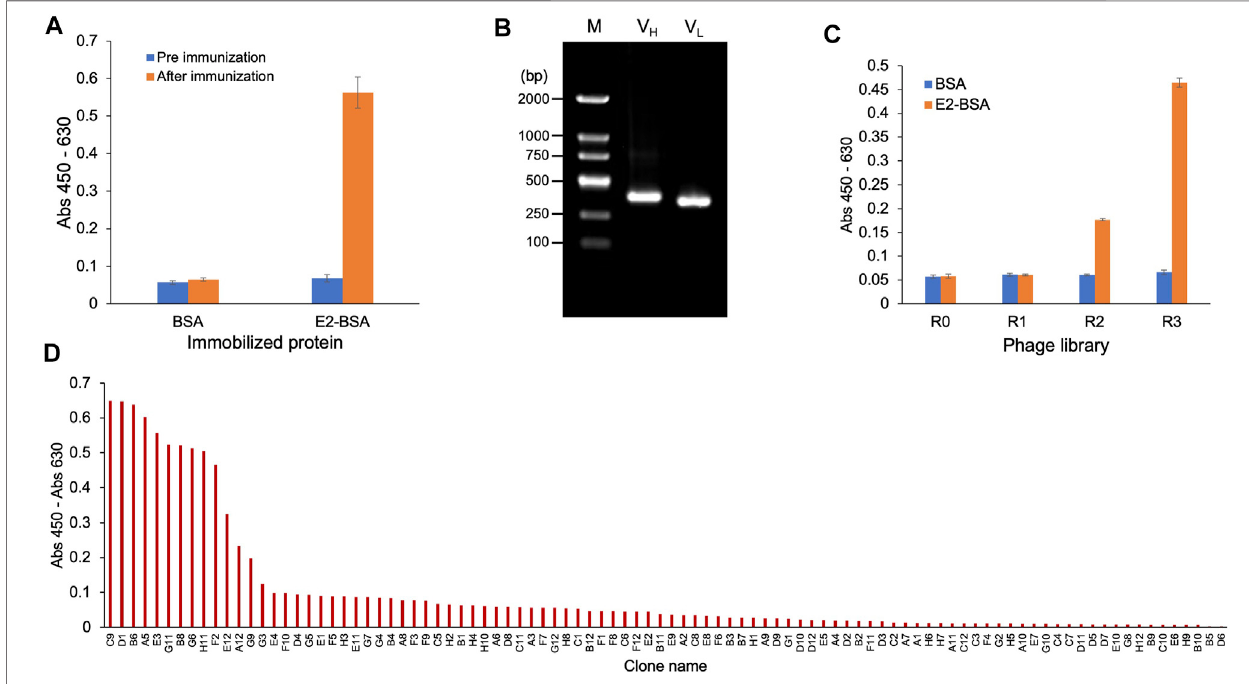
FIGURE2| Cloningofanti-E2antibody. (A) ELISAofanti-E2 antibody intheseraofmice beforeand after immunization; (B) Geneampli fi cation product ofV H gene (400 bp) and V L gene (slightly smaller than V H gene); (C) ELISA of phage-displayed anti-E2 antibody; (D) ELISA of monoclonal antibodies screened from the phage displayedantibodylibrary.E2:17 β -estradiol;M:DNAMarker(100 – 2000 bp);V H :variableregionsofheavychain;V L :variableregionsoflightchain;E2-BSA:conjugateof E2 and bovine serum